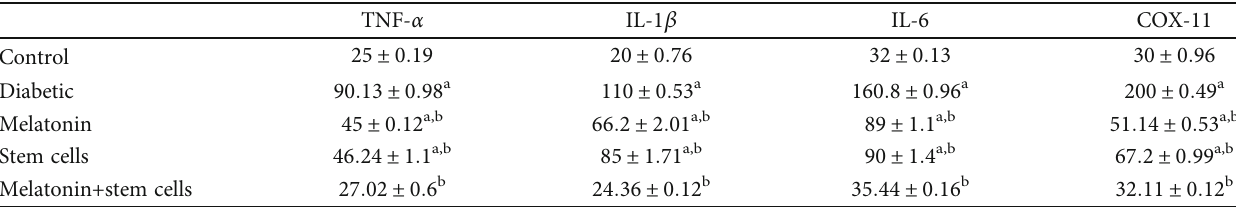
Table 3: Changes of retinal in fl ammatory markers in di ff erent treated